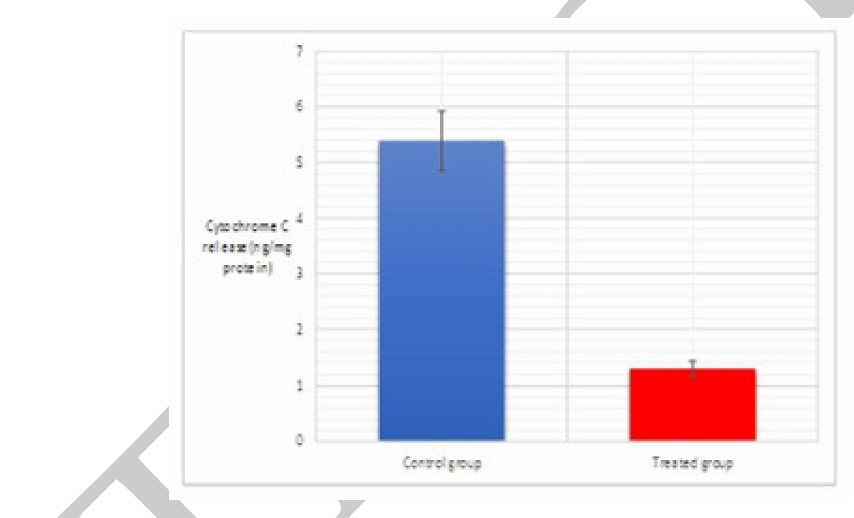
Figure 8. Cytochrome-C in the serum were detected in diabetic untreated and treated group with C. molle.